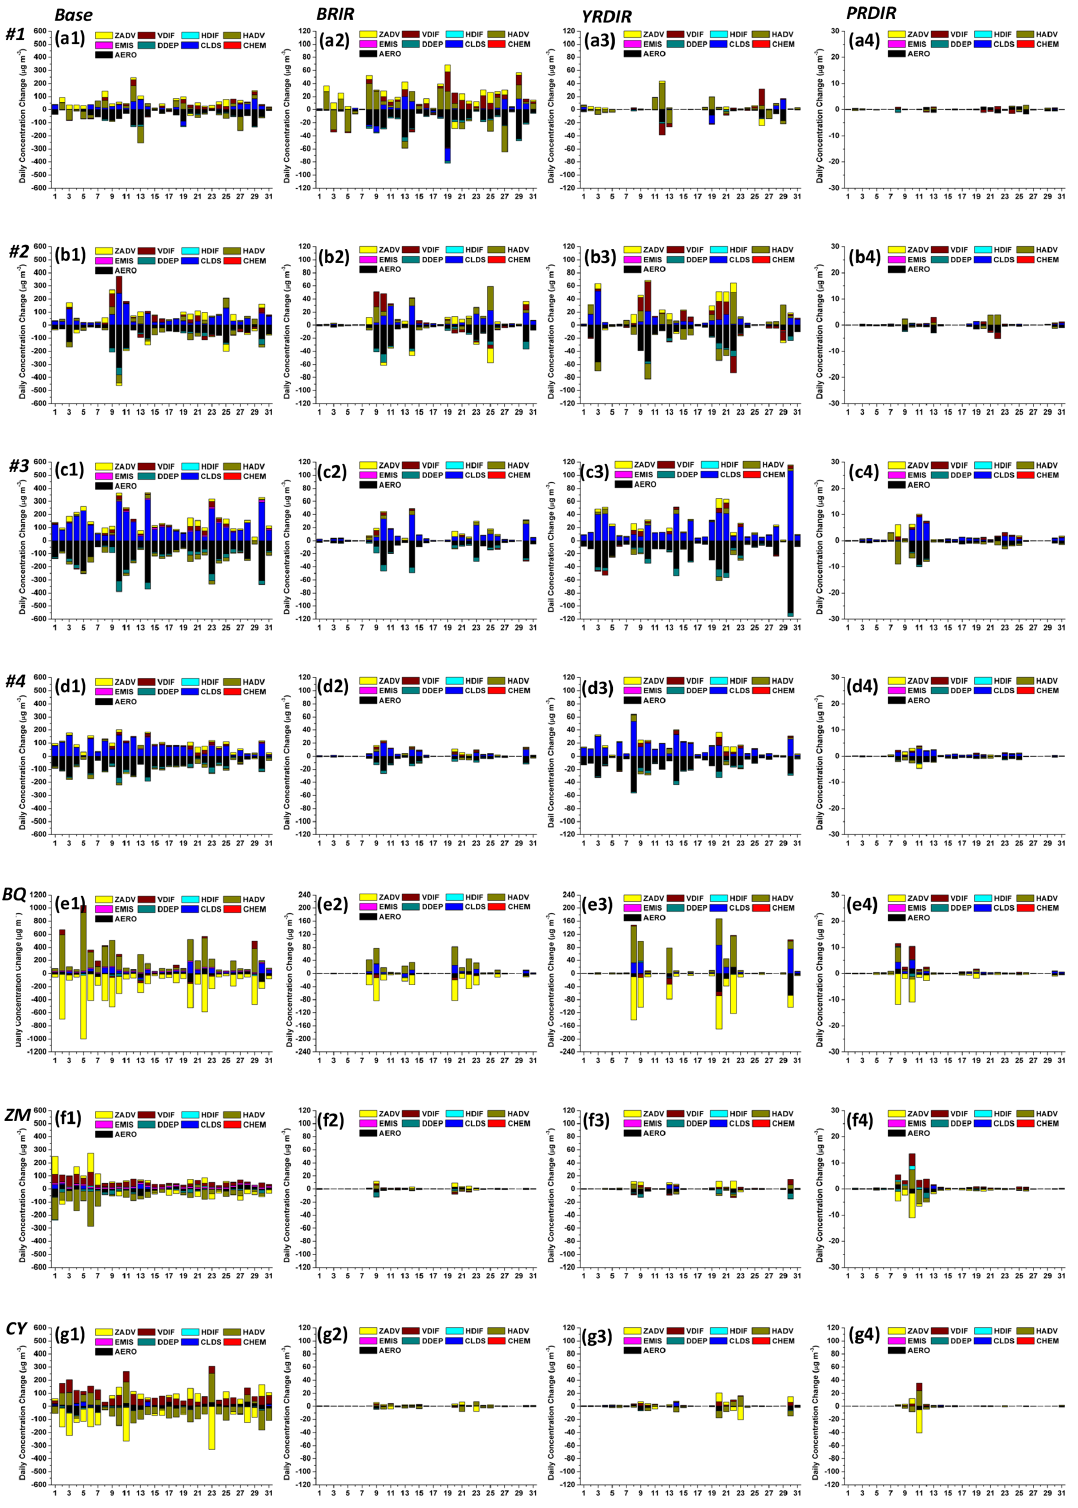
Figure 5. The daily contributions of individual processes averaged over the lower 20 layers to the concentrations of PM 2 . 5 in January 2017. Panels (a) to (g) represent positions 1 to 4 and BQ, ZM, and CY in Fig. 1, respectively. The influence of total emissions (base case), BRIR, YRDIR, and PRDIR are shown by (1) , (2) , (3) , and (4) ,